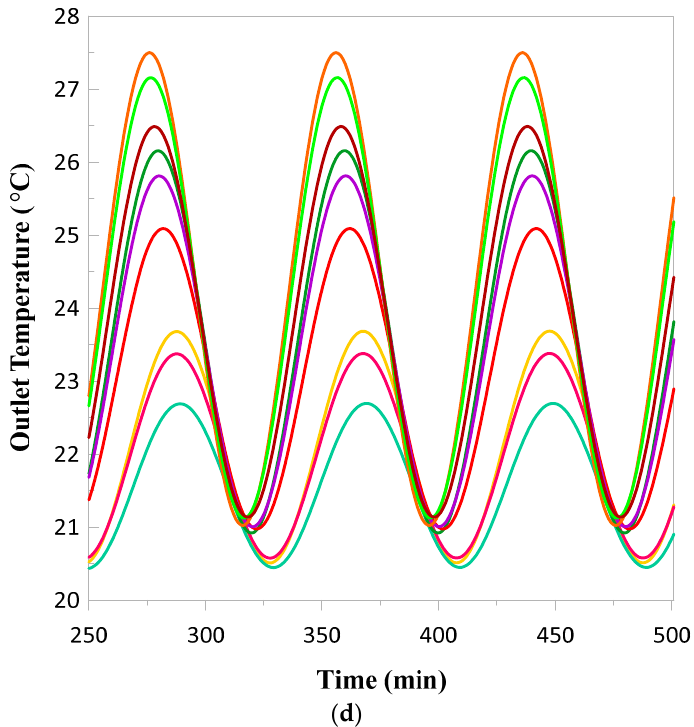
Figure 8. Fluid temperature trends under di ff erent velocities: ( a ) simple U-tube; ( b ) U-tube with outer fins; ( c ) U-tube with inner fins; ( d ) comparison of simple and finned pipes. Table 8. Output wave parameters with a frequency of 1 / 4800 Hz at di ff erent velocities. Velocity Amplitude of Wave (m / s) ( ◦